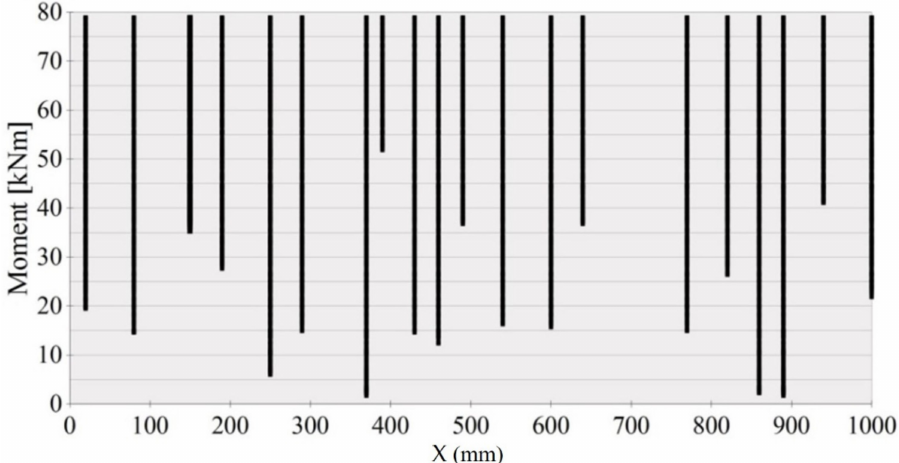
Figure 25. Crack formation and density under loading—beam A2M-1.